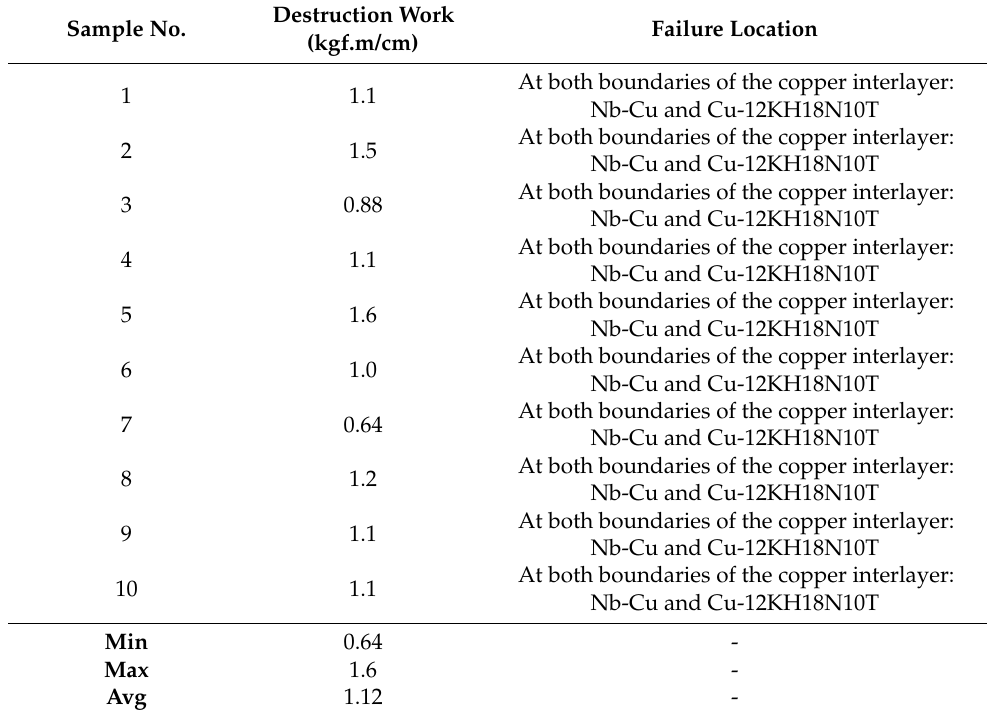
Table 13. Impact strength test results.